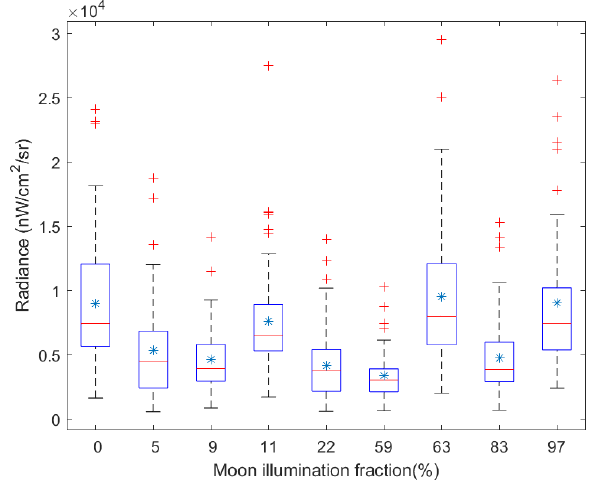
Figure 9. The influence of moon illumination on satellite-observed radiance in the selected area under different lunar illumination fractions of nine days, including 26 November 2021, 3 January 2022, 4 February 2022, 14 March 2022, 30 March 2022, 4 April 2022, 10 April 2022, 15 April 2022, and 26 April 2022. Marker ‘+’ represents the outlier above the upper boundary line, marker ‘ ❊ ’ represents the mean of the group of data, and the red line in the box is the median of the group of data. The spectrum of urban nightlight sources was investigated to better understand the potential impact of atmospheric absorption on the inversion results (Figure 10). We ana- lyzed the difference in the atmospheric spectral transmittance from 350 – 950 nm (without aerosol), the spectral characterization of the three main light sources in cities, and the rel- ative spectral response of the SDGSAT-1/GLI panchromatic bands. The spectral ranges of three main urban light sources mainly cover 300 – 700 nm, which means that a large part of the atmospheric absorption can be avoided in AOD inversion [39]. The light source datasets were collected from the light spectrum database (https://lspdd.org/app/en/home (accessed on 13 July, 2022)). In addition, some trace gases, such as ozone and nitrogen dioxide, may slightly alter the derived AOD values in the aerosol retrieval processes [40,41]. This effect can be quantified by the detailed simulation of the atmospheric transfer model in combination with the reasonable atmospheric observations from the reanalysis datasets. An increase in water vapor will alter the size of aerosol particles, causing changes in the optical properties of aerosol [42], which will lead to changes in AOD values. We also found that the wavelengths of three main urban light sources mainly cover 450 – 700 nm. Therefore, the AOD obtained by the SD algorithm may not be accurate if we choose the central wavelength of the panchromatic band 675 nm to derive the AOD, and the char- acteristics of ground light sources may be one of the factors that make the SD algorithm overestimate the AOD.